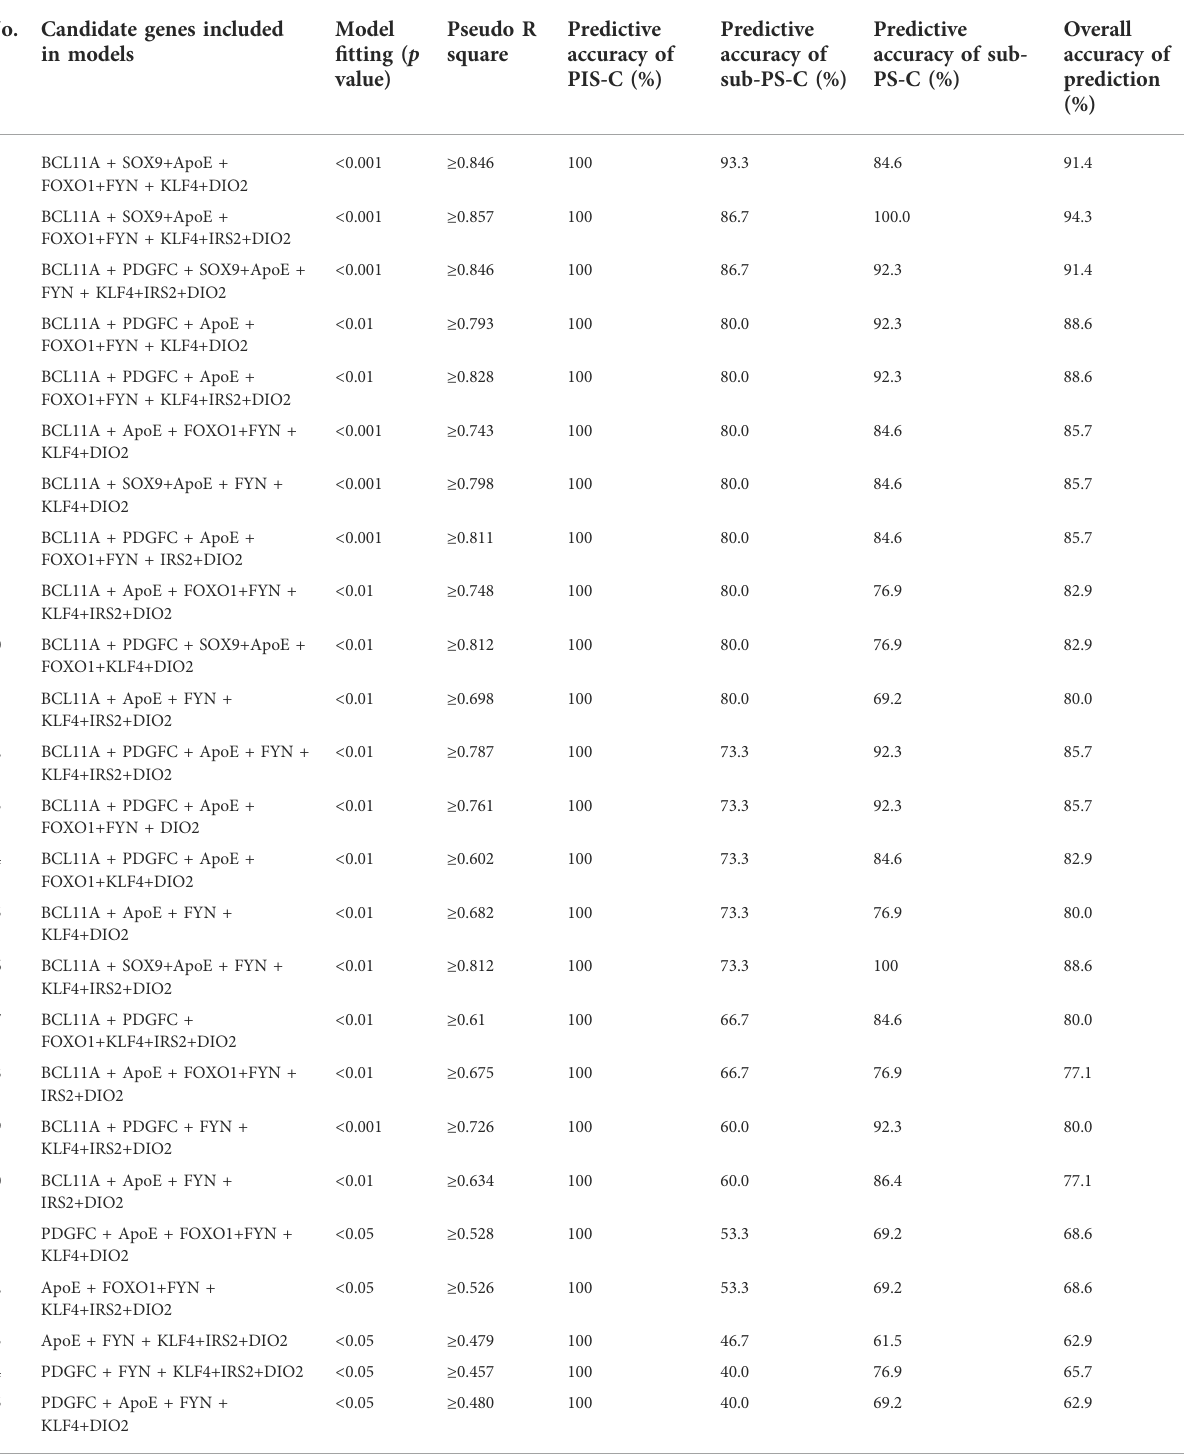
TABLE 3 Characteristics of different predictive models based on candidate